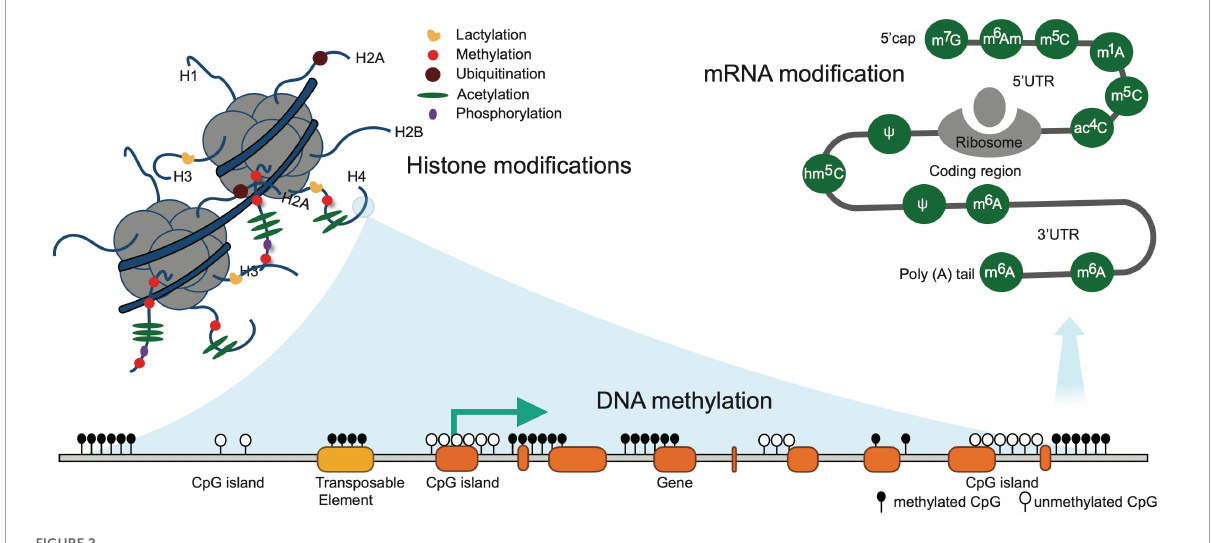
FIGURE2 Illustrates common epigenetic modifications in stroke. DNA methylation occurring exclusively at the CpG island is associated with gene silencing and is irreversible modifications. Known histone modifications occurring at the amino-terminal tails are short-term reversible modifications. RNA modifications are the chemical alteration of the RNA molecules post transcription that alters the expression of